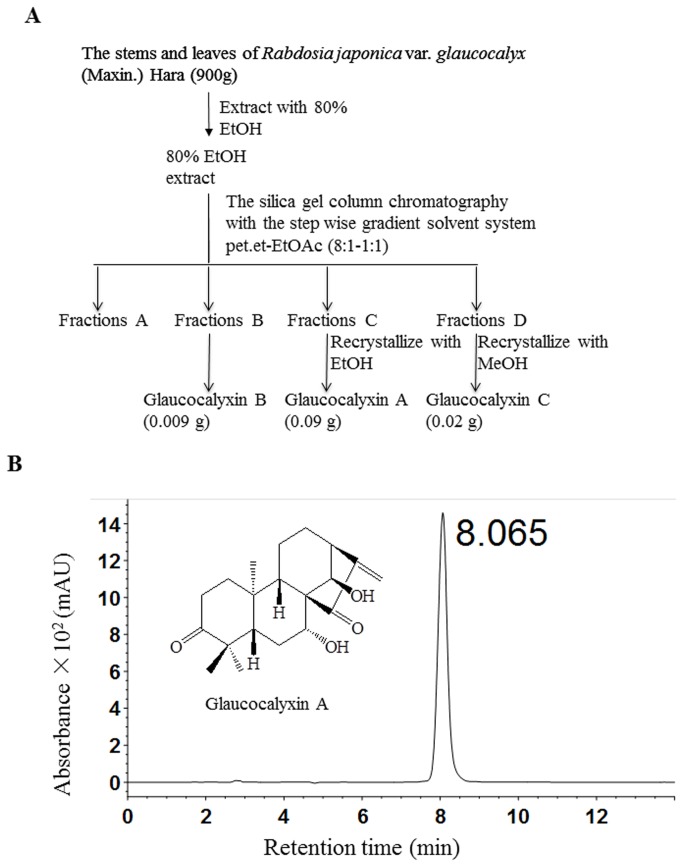
Isolation and identification of Glaucocalyxin A.
Rabdosia japonica (Burm. f.) var. glaucocalyx (Maxim.) Hara were chopped and extracted, and the extract was applied to column chromatography. GLA, GLB, and GLC were obtained from the fraction C, fraction B, and fraction D, respectively (A). The isolated GLA was further confirmed by HPLC and its purity is 98% (B).